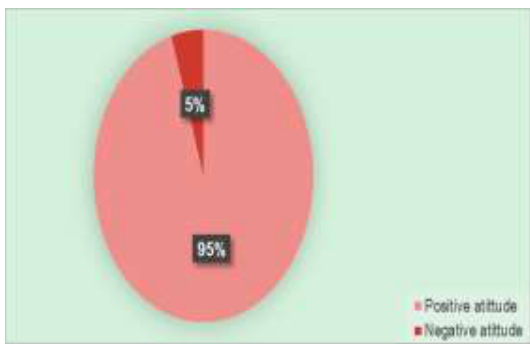
Figure 3. Attitude of community pharmacists toward